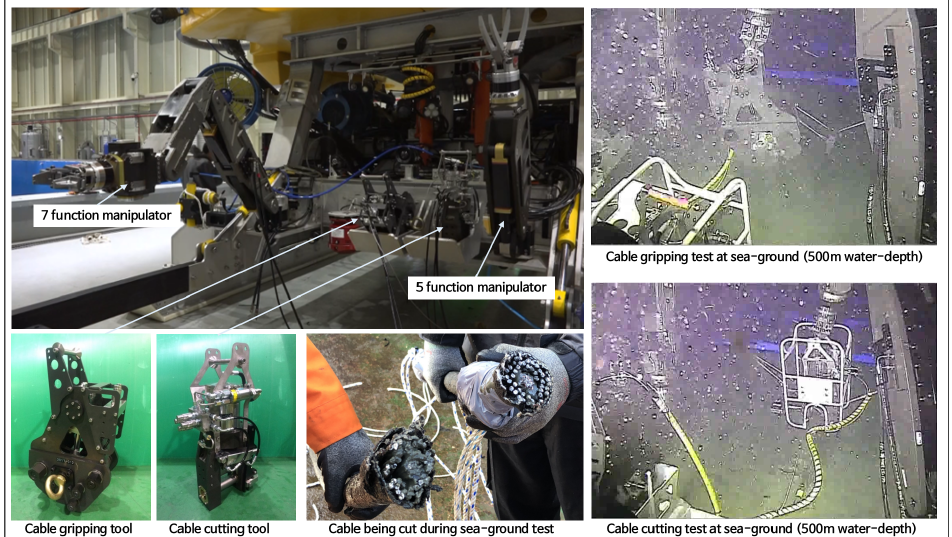
Figure 2. Manipulators and tools for cable